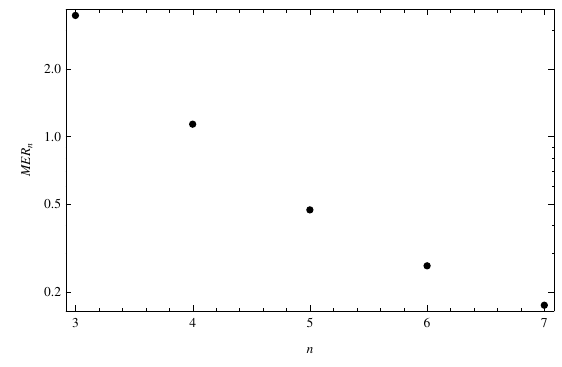
Figure 12: Logarithmic plots of MER n for n = 3, 4, 5, 6, 7